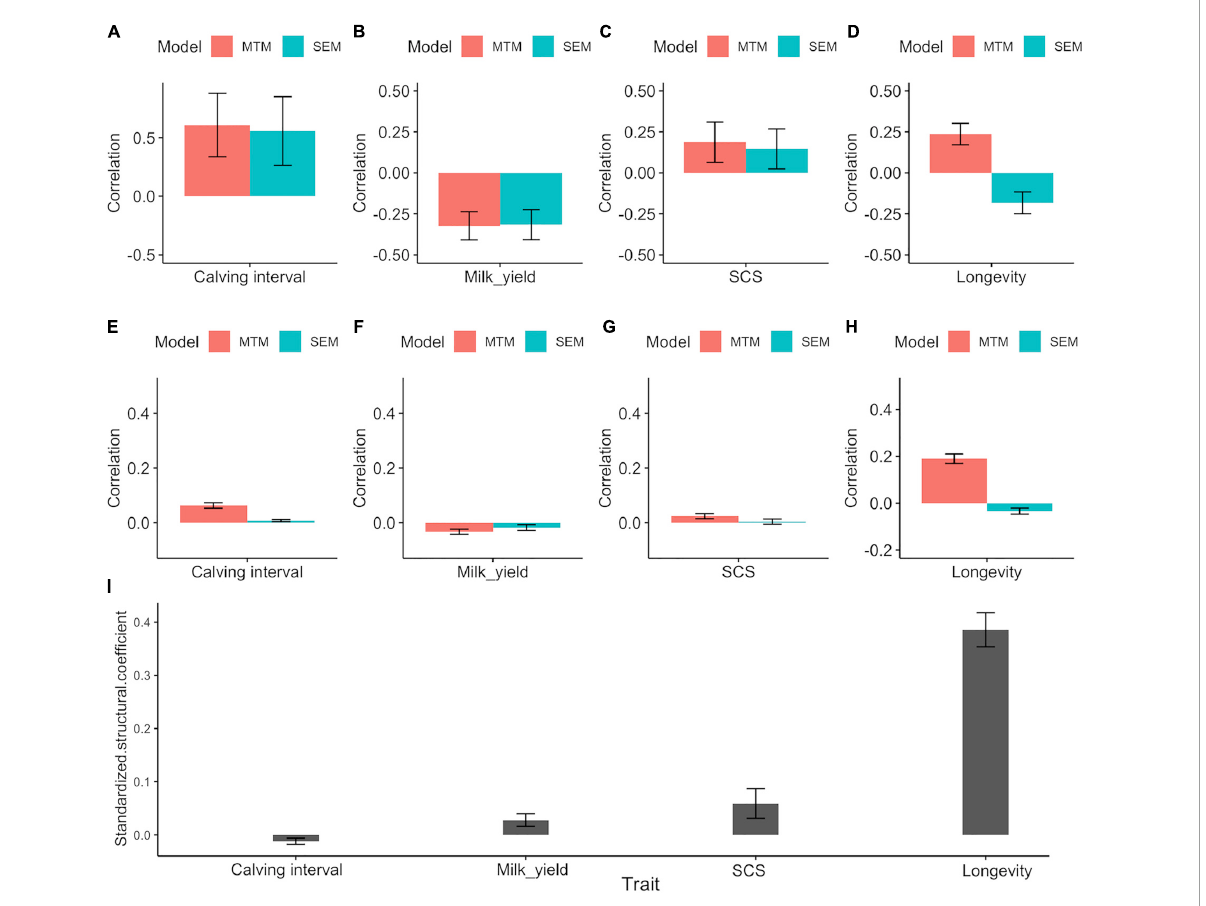
FIGURE1 (A–H) Posterior means ± standard deviation (SD) for genetic and phenotypic correlations between fighting ability and the other traits under MTM and SEM. (A) Genetic correlation with calving interval. (B) Genetic correlation with milk yield. (C) Genetic correlation with SCS. (D) Genetic correlation with longevity. (E) Phenotypic correlation with calving interval. (F) Phenotypic correlation with milk yield. (G) Phenotypic correlation with SCS. (H) Phenotypic correlation with longevity. (I) Posterior means ± standard deviation (SD) for the standardized structural coefficient ( λ 2 ← 1STD ) obtained via SEM for the causal effect of fighting ability (FIGH) on the other traits considered.